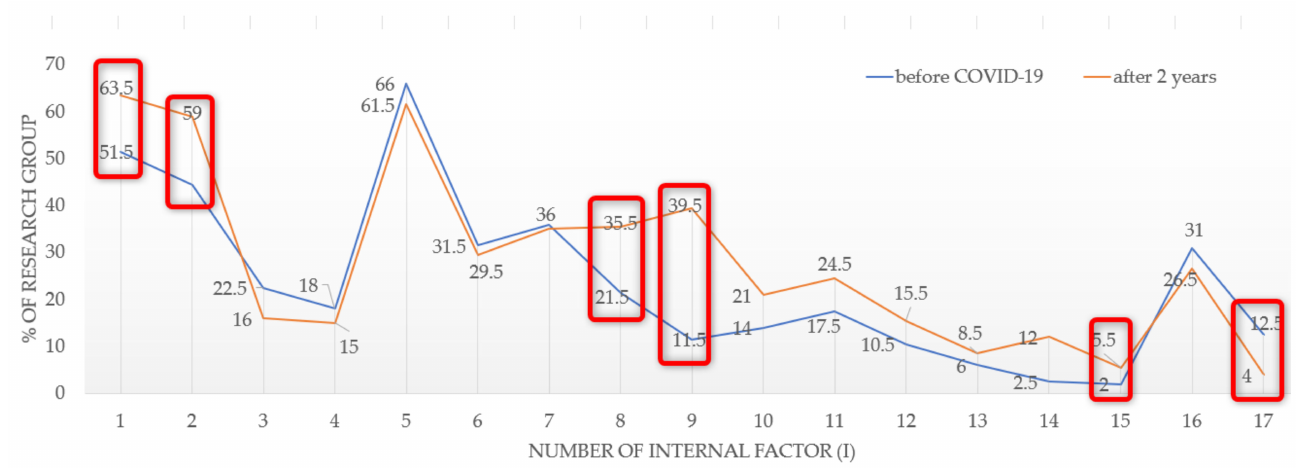
Figure 7. A change in preferences in the housing type attributes after two years of COVID-19. Source: own